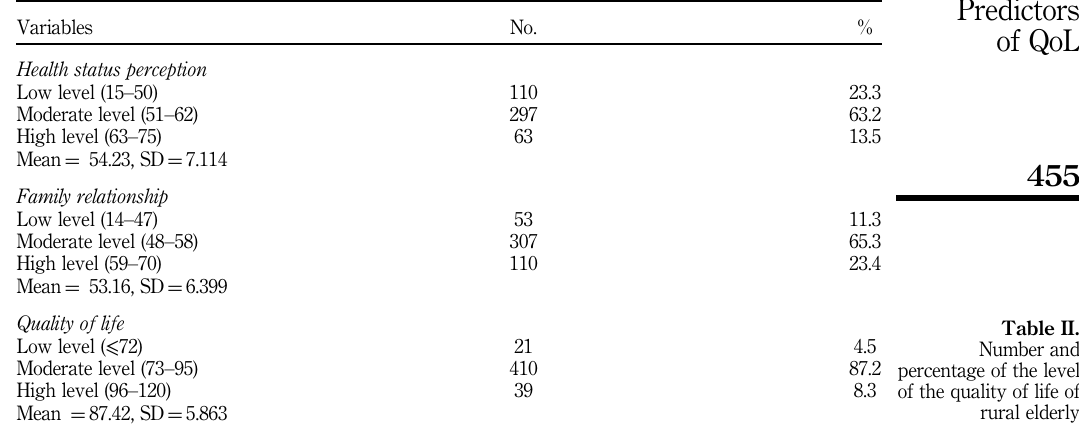
percentage of the level of the quality of life